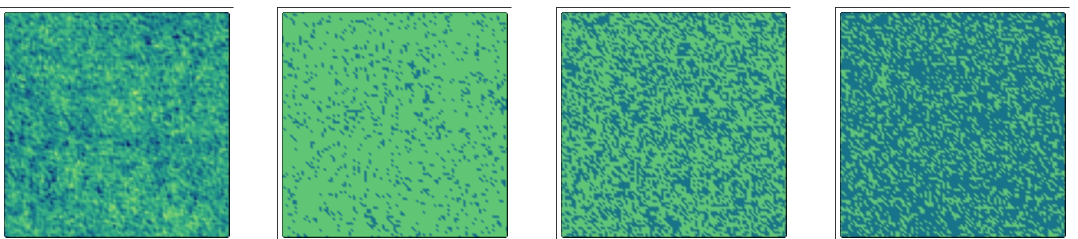
Figure 8 . A sample two-dimensional slice of χ ( x ) (left) in the position space, and the corresponding ζ ( χ ) for ∆ χ /χ c = 2 , 1 , 1 / 2 (the right three panels). The length unit is arbitrary.